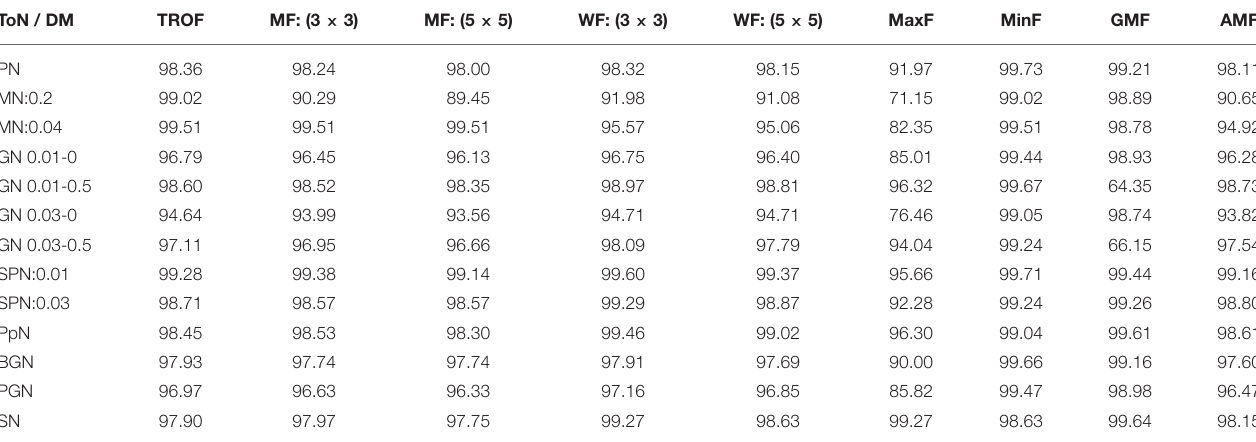
TABLE 6 | Similarity comparison between denoised image and original image.